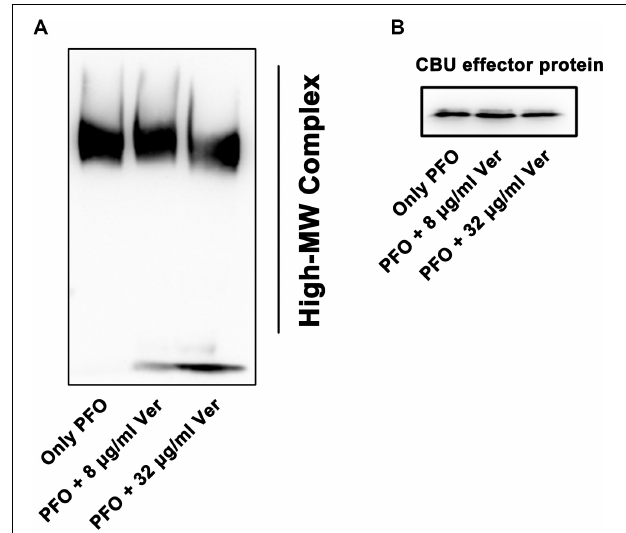
FIGURE 4 | Verbascoside prevents oligomerization of PFO. (A) Oligomerization of PFO pretreated with different concentrations of verbascoside was induced by KCl and rabbit red blood cells in PBS buffer. The formation of oligomers was detected by Western blotting. (B) His-tagged Coxiella burnetii effector protein (30 KD) was used as the loading control and detected with a His-tagged